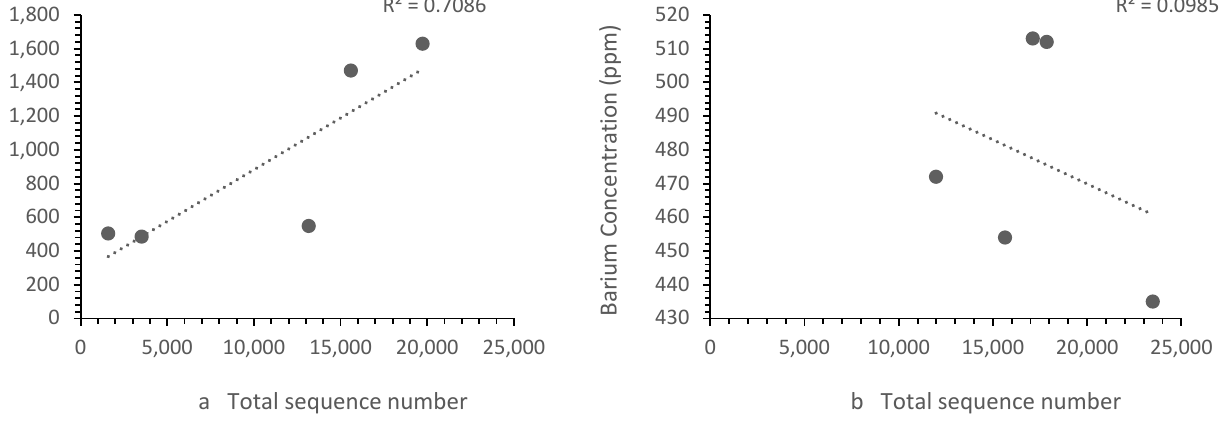
Figure 6. Correlation between ( a ) Zones B, D and E iron concentrations vs. the sequence number, where the sequence number increased as the iron concentration falls and ( b ) the Zone F (i.e., landfill leachate) iron concentration vs. the sequence number, where the sequence number increased with iron concentration. Each point represents a sample site. For iron, the relationship differed in the landfill leachate. R² = 0.7086